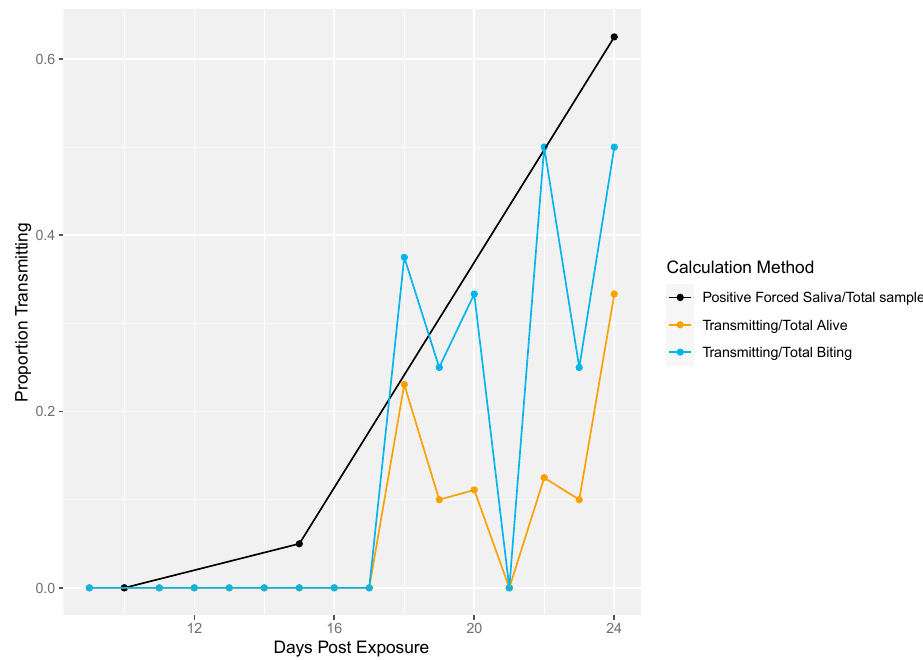
Figure 7. Field-derived transmission profile. Traditional vector competence was calculated as the proportion of mosquitoes with positive forced saliva divided by the number sampled (black line). The total number of transmitting mosquitoes over the total number of living mosquitoes was calculated per sampling day (yellow line). Lastly, the total number of transmitting mosquitoes over the total number of mosquitoes that exhibited biting behavior was calculated per sampling day (blue line).